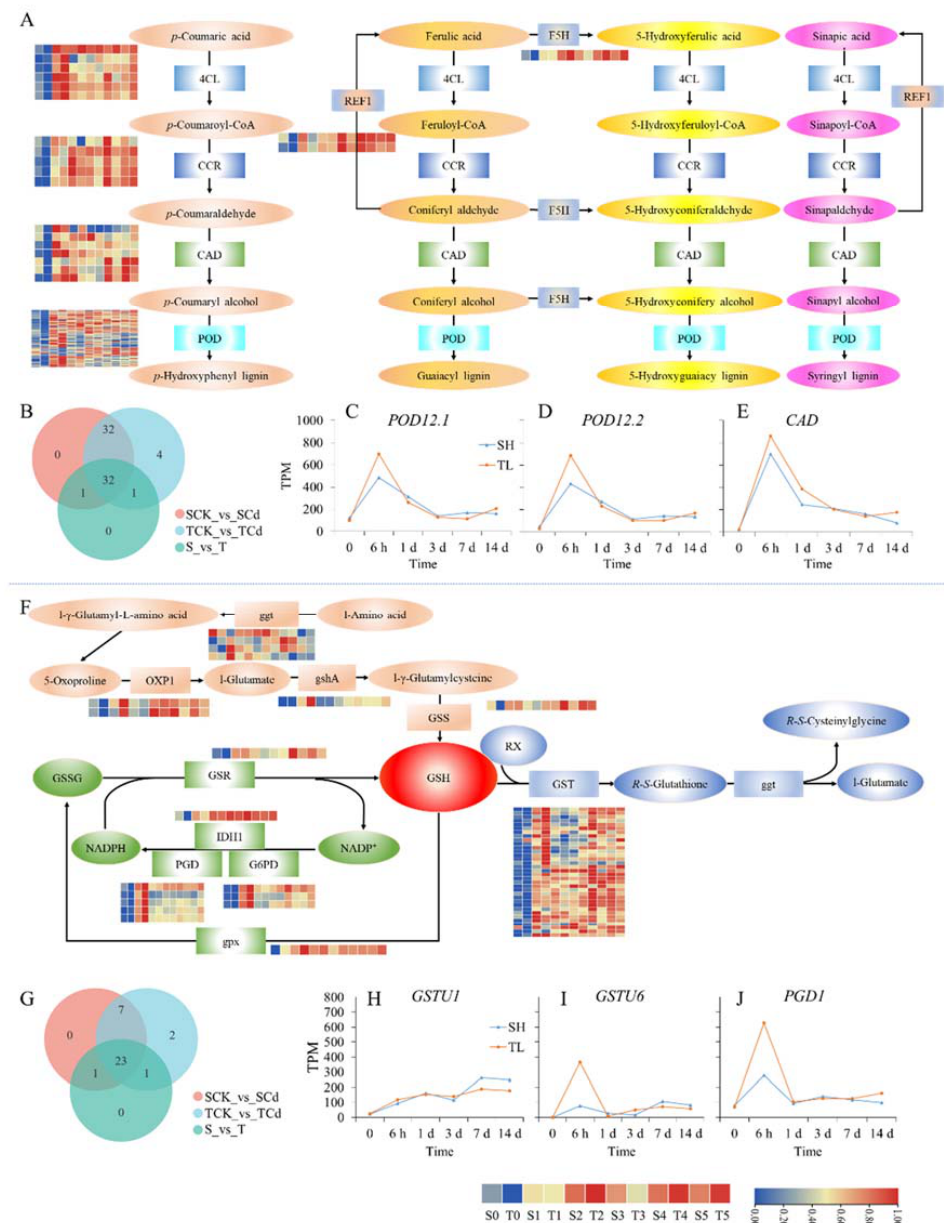
Figure 7. Expression pattern analysis of differentially expressed genes (DEGs) involved in phe ‐ nylpropanoid biosynthesis pathway ( A ) and glutathione metabolism pathway ( F ); Venn diagrams of PODs ( B ) and GSTs ( G ); and expression analysis of POD12.1 ( C ), POD12.2 ( D ), CAD ( E ), GSTU1 ( H ), GSTU6 ( I ), and PGD1 ( J ). SCK_vs._SCd, TCK_vs._TCd, and S_vs._T represent DEGs between control and Cd treatments in the Cd ‐ sensitive variety, between control and Cd treatments in the Cd ‐ tolerant variety, and between the two varieties, respectively. REF1, 4CL, CCR, CAD, F5H, ggt, OXP1, gshA, GSS, GSR, IDH1, PGD, G6PD, gpx, and GST represent coniferyl ‐ aldehyde de ‐ hydro ‐ genase, 4 ‐ coumarate ‐ CoA ligase, cinnamoyl ‐ CoA reductase, cinnamyl ‐ alcohol dehydrogenase, fer ‐ ulate ‐ 5 ‐ hydroxylase, gamma ‐ glutamyltranspeptidase, 5 ‐ oxoprolinase (ATP ‐ hydrolyzing), gluta ‐ mate ‐ cysteine ligase, glutathione synthase, glutathione reductase (NADPH), isocitrate dehydrogen ‐ ase, 6 ‐ phosphogluconate dehydrogenase, glucose ‐ 6 ‐ phosphate 1 ‐ dehydrogenase, glutathione pe ‐ roxidase, and glutathione S ‐ transferase, respectively.